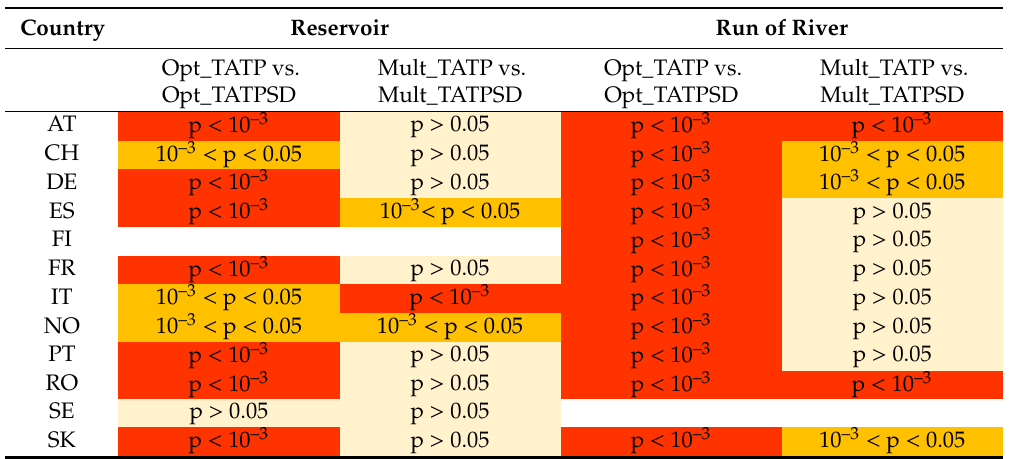
Table 3. Statistical significance test between model configurations with and without snow depth (see Figure 2 for abbreviations used). The results are divided into three categories based on p-value: significantly di ff erent (p < 10 –3 in red), di ff erent (10 –3 < p < 0.05 in orange), and not di ff erent (p > 0.05 in pale yellow). The white colour indicates no available